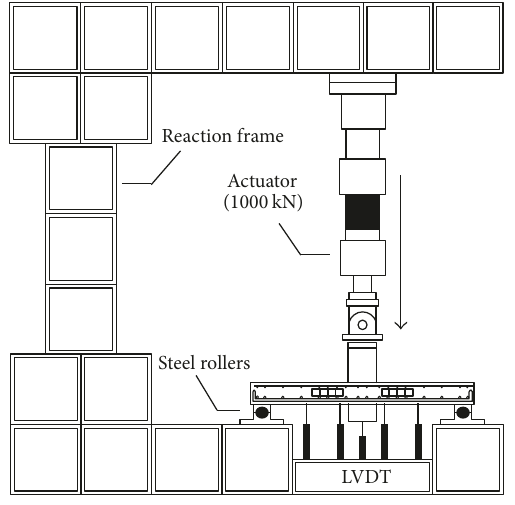
Figure 7: Experimental